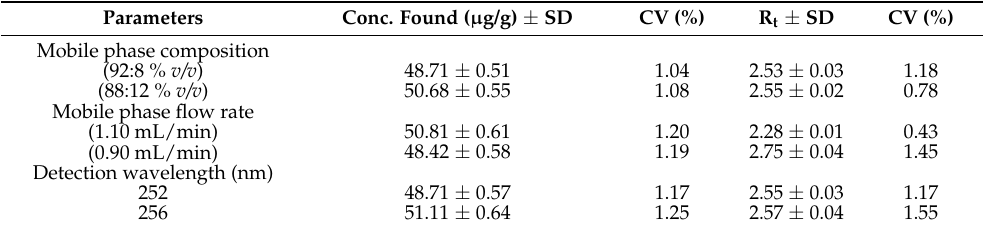
Table 6. Robustness results of PTT at MQC (50 µ g/g) for the HPLC approach (mean ± SD; n =